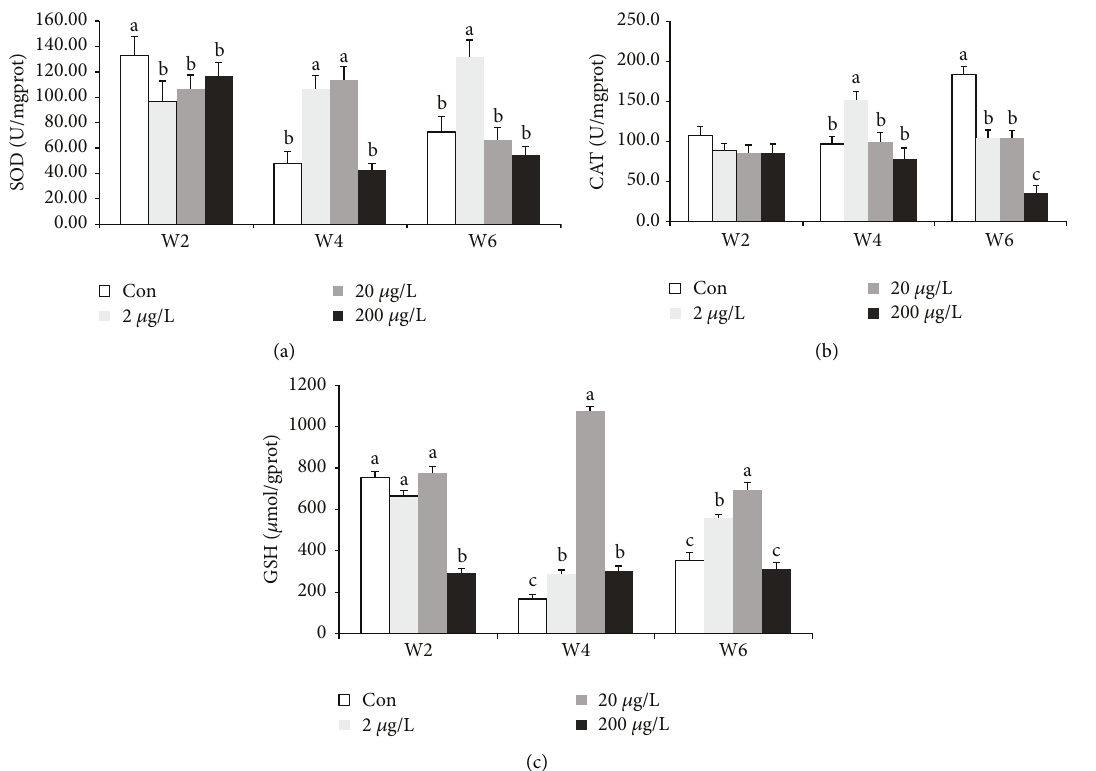
Figure 2: Combined view of SOD, CAT, and GSH concentrations in the liver of GIFTexposed to METcontaminated water at w2, w4, and w6. Different subscripts in each group indicate significant difference. The treatment for 0, 2, 20, and 200 μ g/L METin triplicate (n � 12 total tanks for 4 groups and n � 15 individuals per tank in